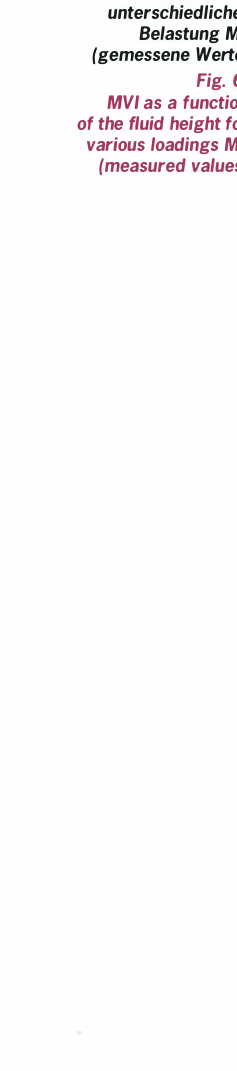
Fig. 6: MVI as a function of the fluid height for various loadings Mo (measured